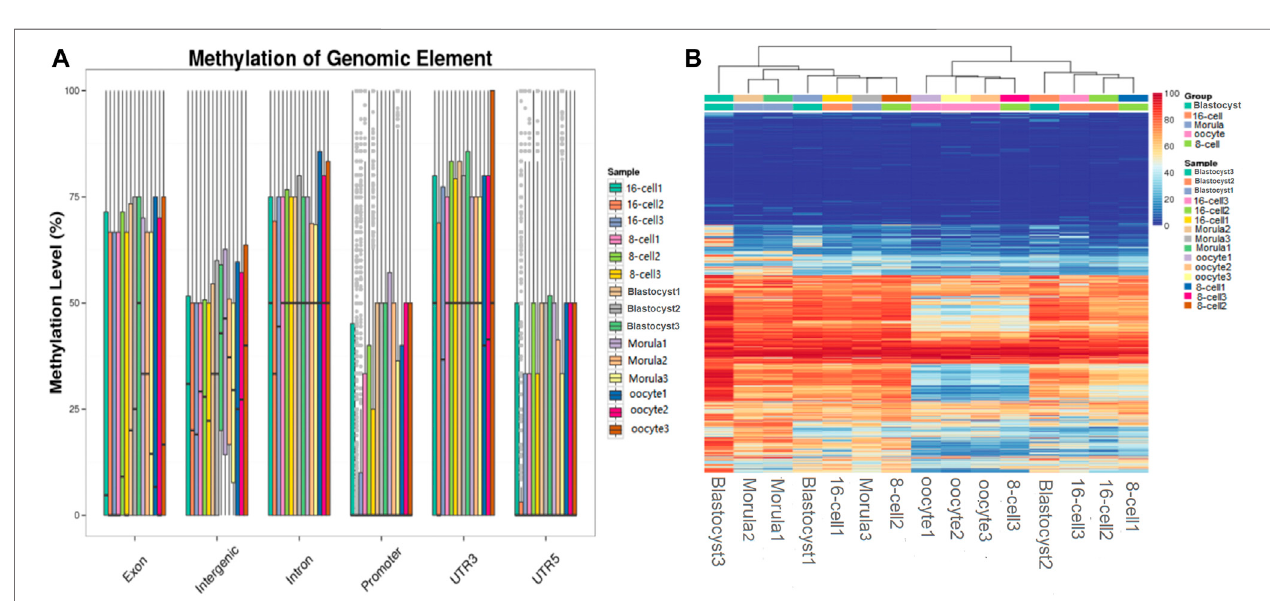
FIGURE3| Functionalregionmethylationannotationandclusteranalysisofdifferentialsites. (A) Methylationleveldistributionindifferentgenomefunctionalregions. The horizontal axis represents different functional regions in the genome; the vertical axis represents the methylation level of different samples. (B) Clustering map of the CpGsitemethylationlevel.TheCpGsitessharedbythecellsamplesweresearchedandthemethylationlevelsofeachsitewerecalculated.Subsequently,theCpGsites wereclusteredbasedonthemethylationlevel,andthesametypeofcellswereclusteredtogethertohaveasimilarmethylationpattern.EachrowrepresentsaCpG site, and each column represents a cell sample and the right scale value is the methylation level (0 – 100).